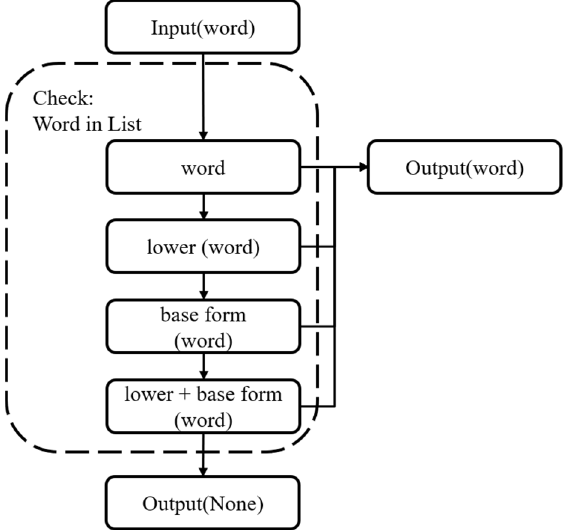
Figure 2. Process of word